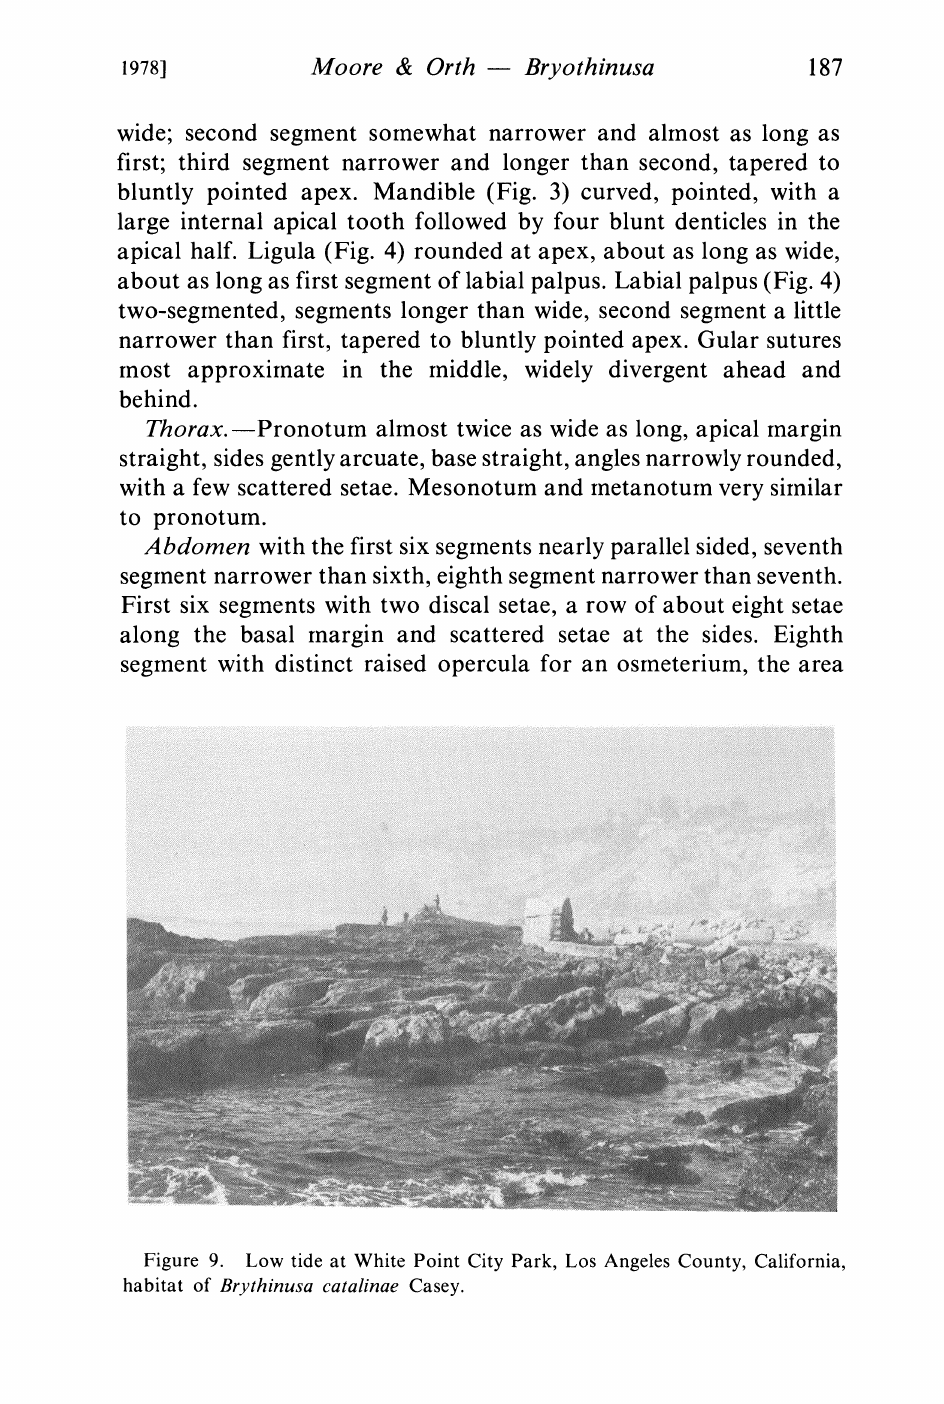
Figure 9. Low tide at White Point City Park, Los Angeles County, California, habitat of Brythinusa catalinae